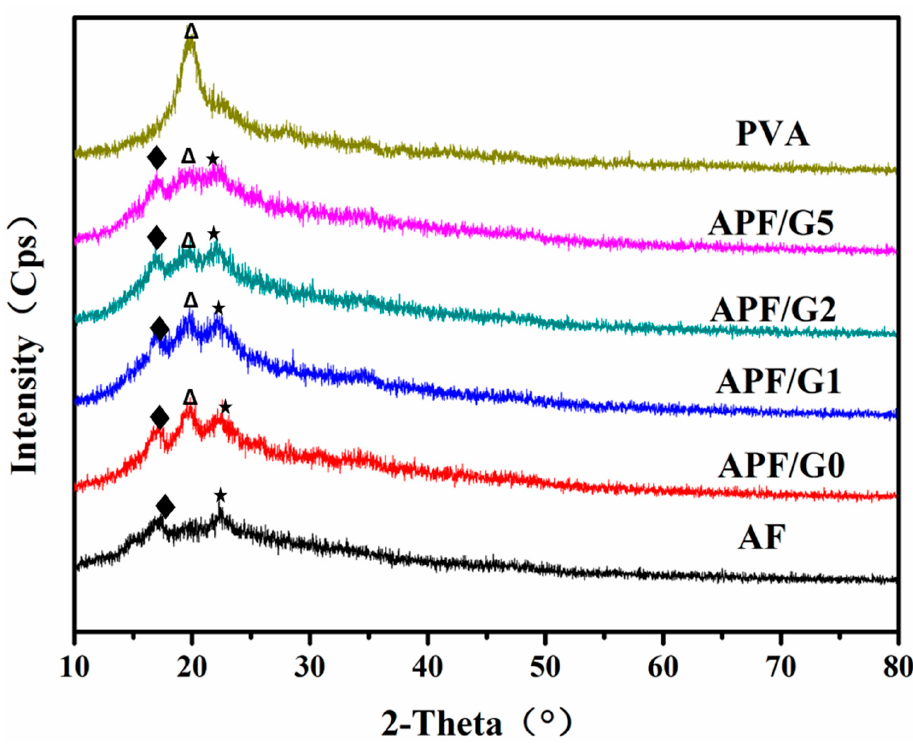
Figure 4. WAXS of APF/G (0, 1, 2 and 5), AF and pure PVA film. Table 3. Relative crystallinity degree (%) of samples with different concentrations of cross-linking agent.